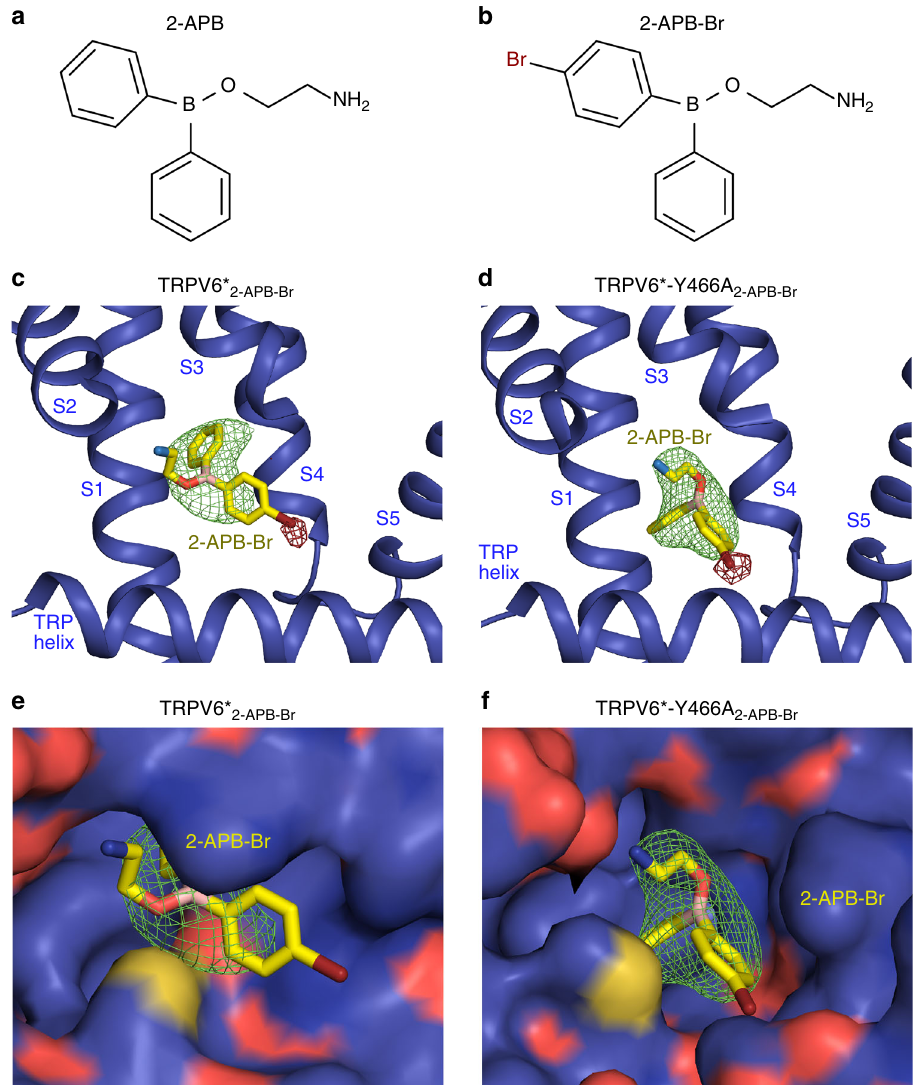
Fig. 3 Binding of brominated 2-APB to TRPV6* and TRPV6*-Y466A. a , b Chemical structures of 2-APB ( a ) and 2-APB-Br ( b ). c , d Close-up view of the 2-APB binding site in TRPV6* 2-APB-Br ( c ) and TRPV6*-Y466A 2-APB-Br ( d ). The molecule of 2-APB-Br is in stick representation, with the Fo – Fc omit map (2.5 σ ) shown as a green mesh and the anomalous difference Fourier maps at 3 σ for TRPV6* 2-APB-Br and 5.5 σ for TRPV6*-Y466A 2-APB-Br shown as a brown mesh. e , f Surface representation of the 2-APB binding pocket in TRPV6* 2-APB-Br ( e ) and TRPV6*-Y466A 2-APB-Br ( f ). Note the different orientations (poses) of the 2-APB-Br molecule in the two